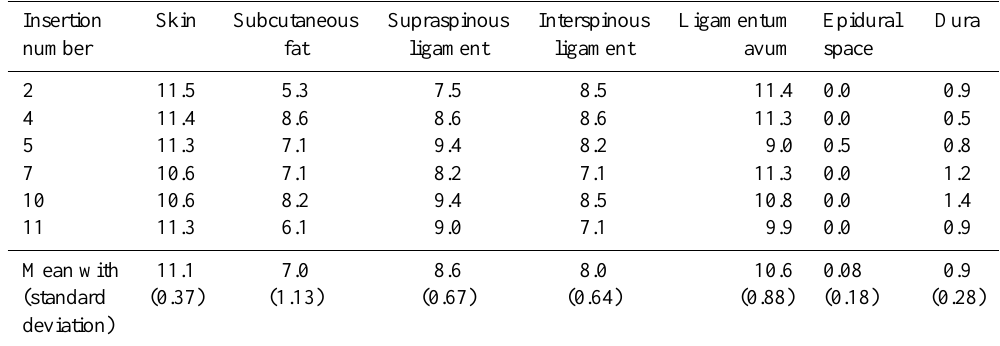
Mean with (standard deviation)